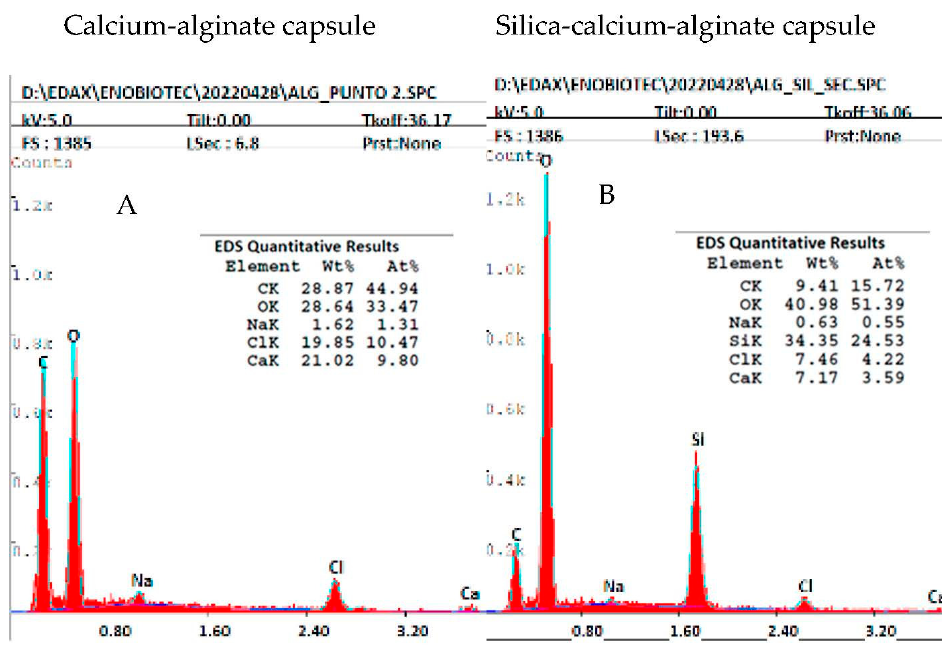
Figure 3. Microstructural characterization of calcium-alginate ( A ) and silica-calcium-alginate ( B ) capsules.